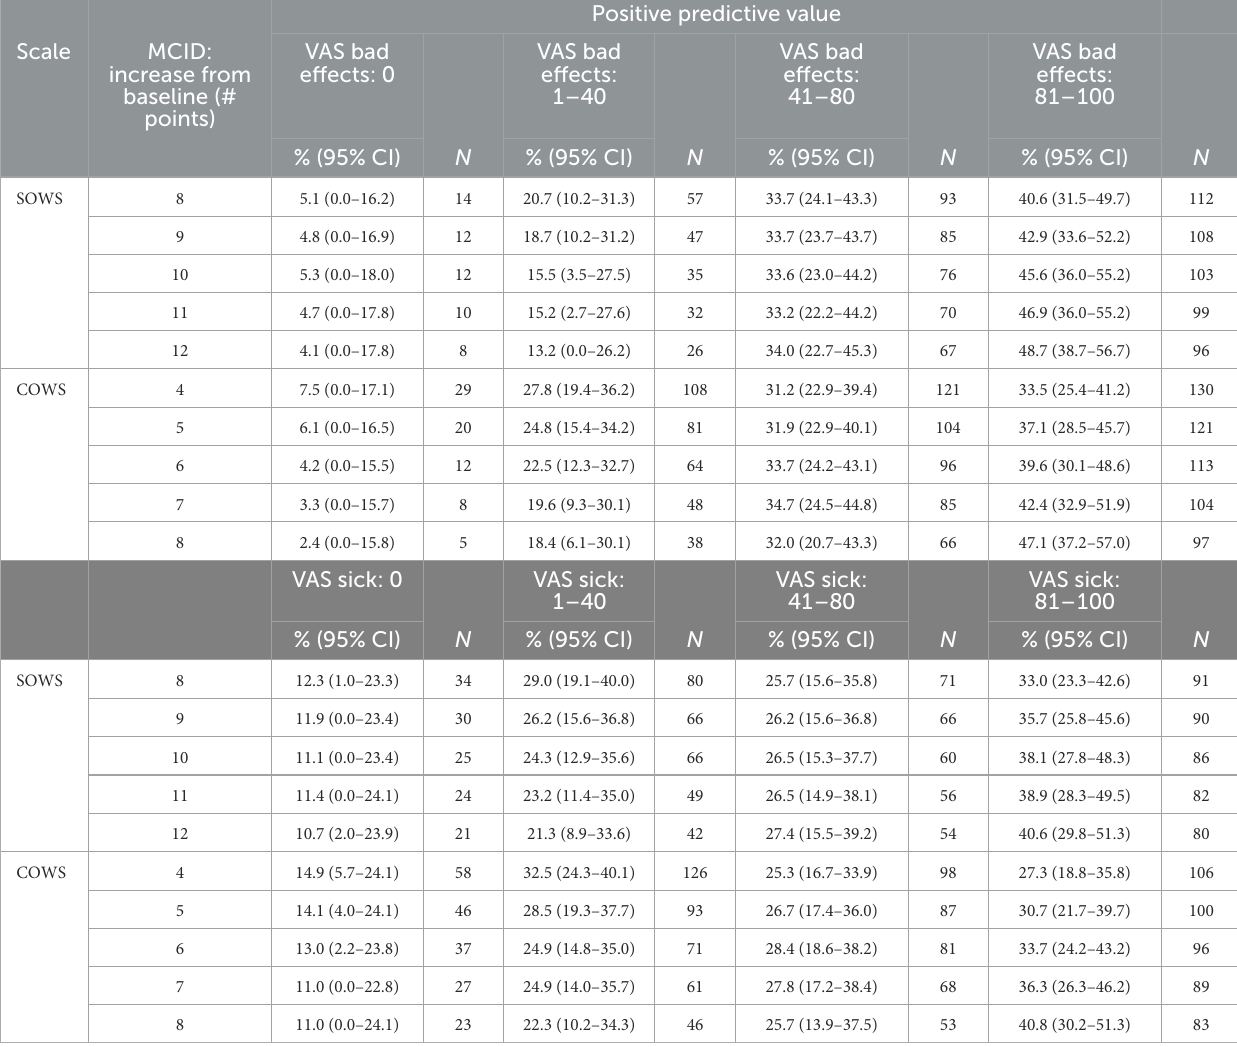
TABLE 1 Minimal clinically important different (MCID) to predict change in VAS severity